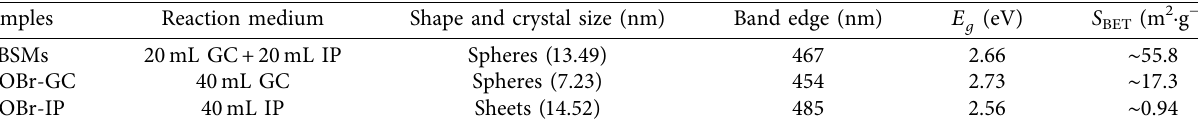
Table 1: Summary of detailed parameters of control experiments and corresponding structural data of the HBSMs, BiOBr-GC, and BiOBr- IP products.